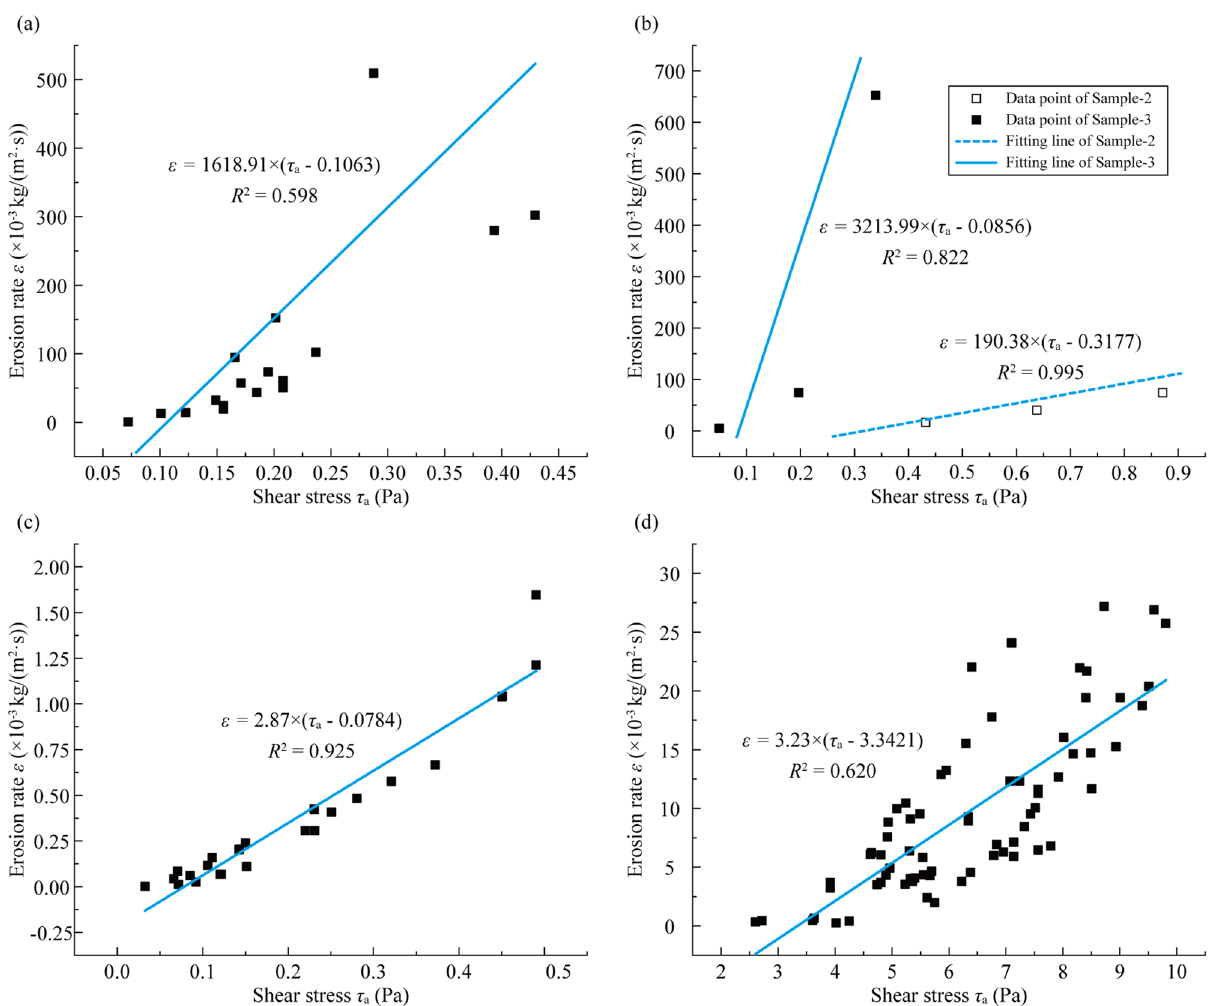
Figure 8. Collected ε − τ c data points and the regression lines: ( a ) Sample-1, ( b ) Sample-2 and Sample-3, ( c ) Sample-4, and ( d )